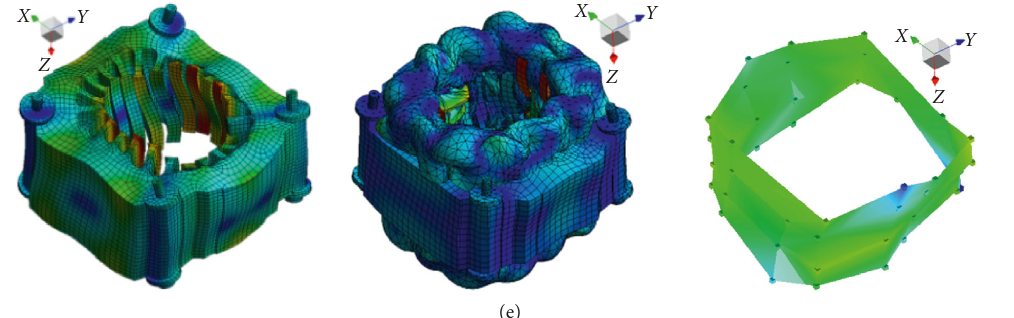
Figure 20: Numerical and experimental modal shapes of the stator adopted for the fitting model: (a) ω N : 1136.9Hz; ω N : 1124.1Hz; ω E : 1084.0Hz. (b) ω N : 1489.8Hz; ω N : 1543.7Hz; ω E : 1477.3Hz. (c) ω N : 3656.5Hz; ω N : 3582.8Hz; ω E : 3621.4 Hz. (d) ω N : 3796.2Hz; ω N : 3884.4Hz; ω E : 3848.4Hz. (e) ω N : 4780.0Hz; ω N : 4990.1 Hz; ω E : 5129.3Hz.